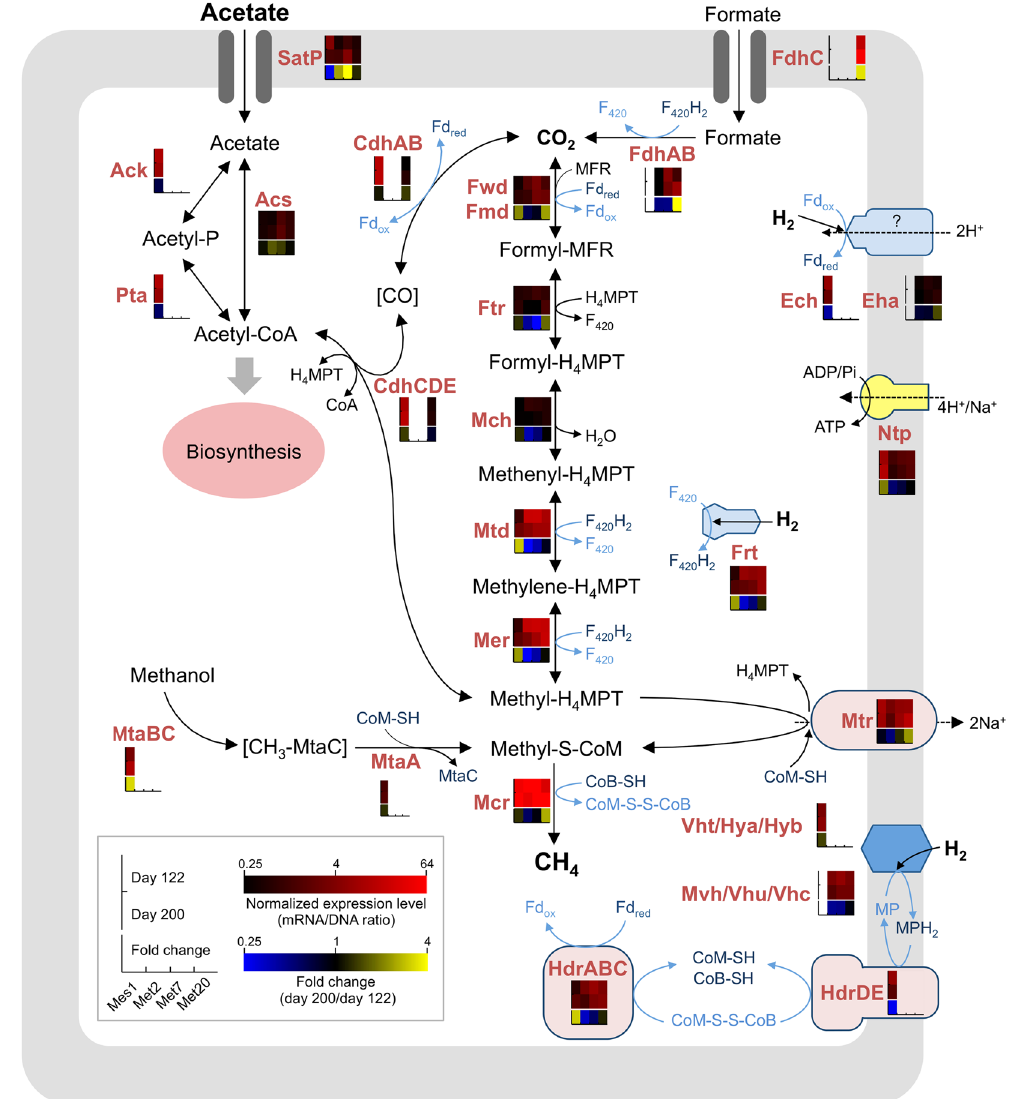
Figure 6. Reconstructed pathways for methanogenesis and associated metabolism in the four methanogens and their gene-expression profiles. Normalized expression levels (mRNA/DNA) and fold changes in the expression level (days 122/day 200) are shown as heatmaps. For an enzyme encoded by multiple subunit genes, average values for each gene are shown. Genes absent from each bin-genome are shown as blanks in heatmap boxes. The pathways are depicted according to previous reports 56, 57, 75, 87–89 . Abbreviations: Fd ox /Fd red , oxidized and reduced ferredoxin; MP/MPH 2 , oxidized and reduced methanophenazine; CoB-SH, coenzyme B; CoM-SH, coenzyme M; CoM-S-S-CoB, mixed disulfide of CoM-SH and CoB-SH; F 420 /F 420 H 2 , oxidized and reduced Factor 420; H 4 MPT, tetrahydromethanopterin; Fwd, tungsten formylmethanofuran dehydrogenase; Fmd, molybdenum formylmethanofuran dehydrogenase; Ftr, formylmethanofuran:H 4 MPT formyltransferase; Mch, methenyl-H 4 MPT cyclohydrolase; Mtd, F 420 -dependent methylene-H 4 MPT dehydrogenase; Mer, methylene-H 4 MPT reductase; Mtr, methyl-H 4 MPT: coenzyme M methyltransferase; Mcr, methyl-coenzyme M reductase; Hdr, heterodisulfide reductase; Ech, energy-converting hydrogenase; Frh, F 420 -reducing hydrogenase; Mvh/Vhu/Vhc/Vht/Hya/Hyb, non F 420 -reducing hydrogenase; AcsS, acetyl-CoA synthetase; Ack, acetate kinase; Pta, phosphotransacetylase; Cdh, CO dehydrogenase/acetyl-CoA synthase;